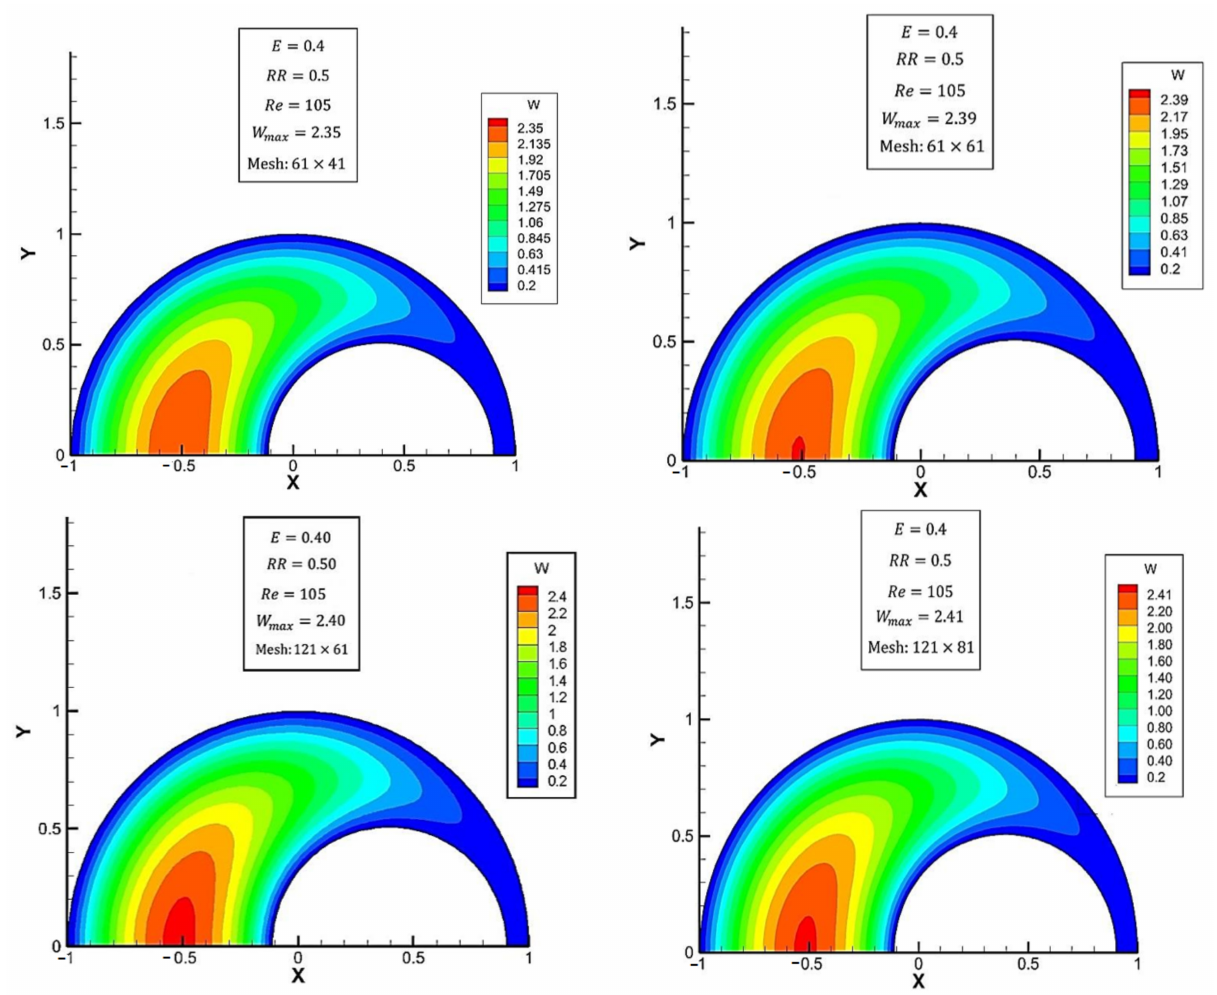
Figure 8. The developed velocity contours in the space of two cylinders filled with a porous medium for various grids.